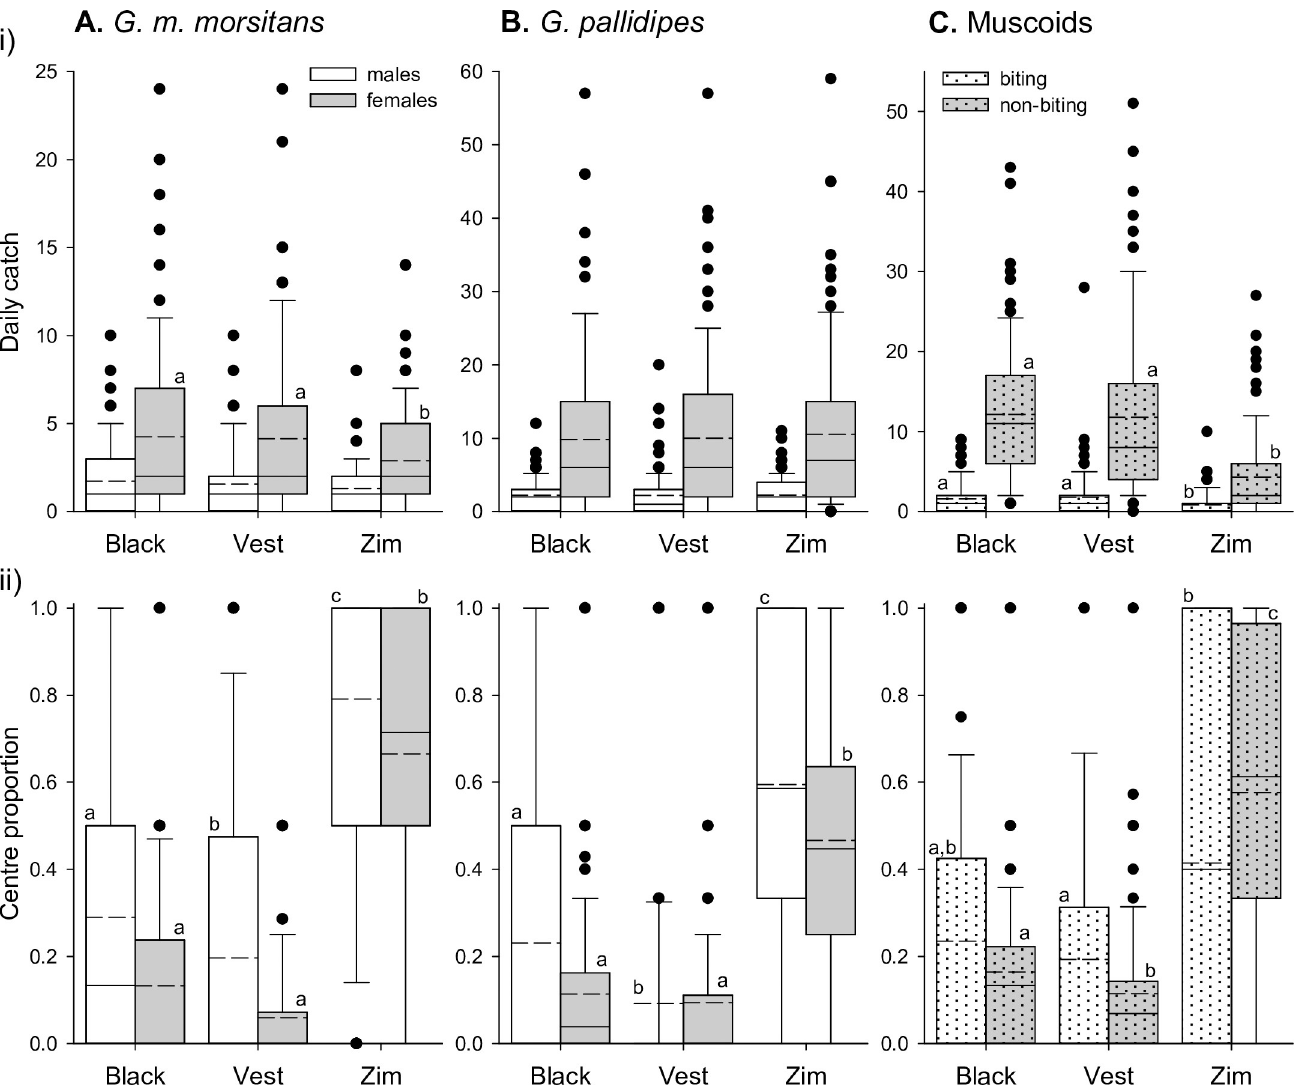
Fig 3. Catches of biting flies at three target designs based on existing technologies. Data are plotted for male and female G . m . morsitans (A), and G . pallidipes (B), and for biting and non-biting muscoid species (C). (i) Upper panels show daily catches recorded on each sampling day. (ii) Lower panels show the proportion of the catch that was intercepted at the centre panel on each sampling day. Target designs are described in Table 1 (Vest = ‘Vestergaard’; Zim = Zimbabwe), and data are from a total of 29 Latin squares encompassing 87 sampling days. Boxes enclose 25 th and 75 th percentiles, with median indicated by solid line, and mean indicated by dashed line. Whiskers indicate 10 th and 90 th percentiles, and outliers are plotted. Different letters indicate significant differences (p < 0.05) as indicated by post-hoc LSD tests. Omnibus tests are reported in